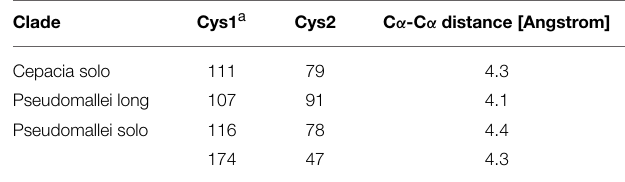
TABLE 1 | Presence of AHL-binding and non-AHL-binding sequence motifs in the LuxR proteins in the Burkholderia genus. LuxR clade